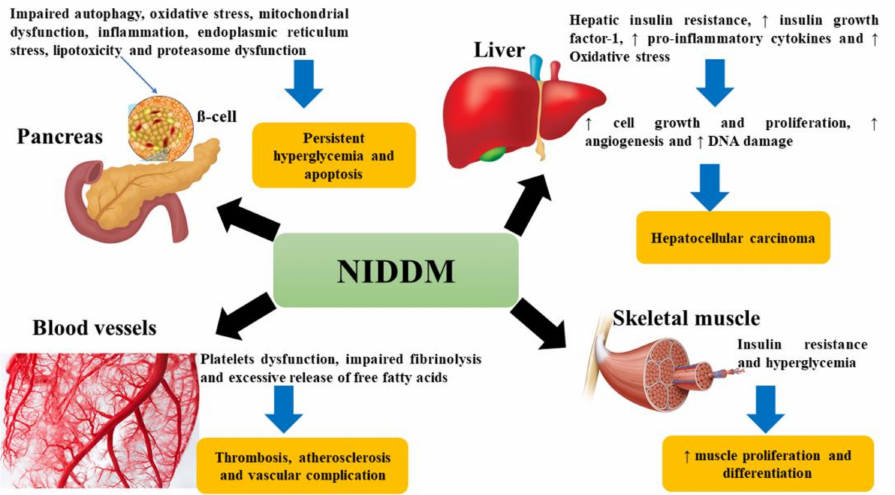
Figure 2. Effect of noninsulin-dependent diabetes mellitus (NIDDM) on liver, pancreas, blood vessels, and skeletal muscle. ER: endoplasmic reticulum, DNA: deoxyribonucleic acid.